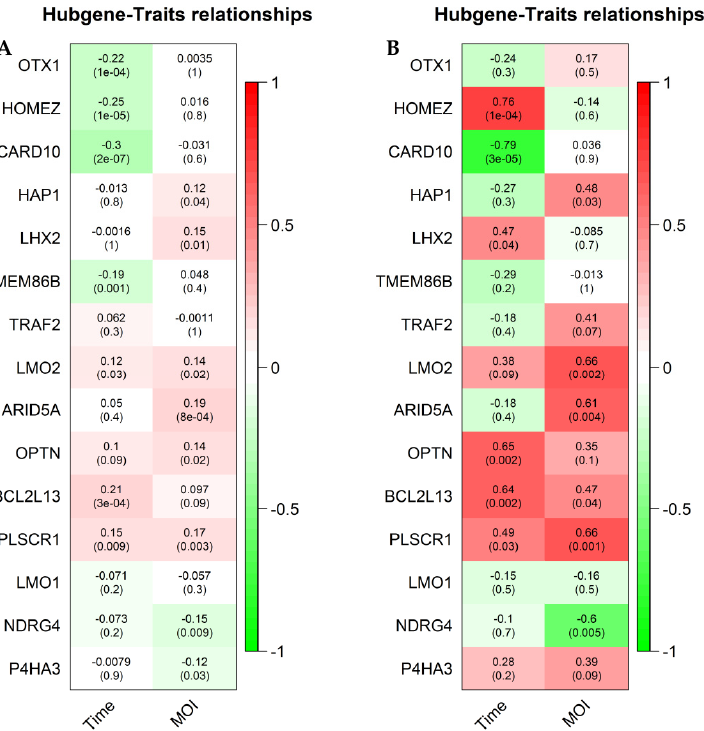
Figure 6. The relationships between top hub genes and traits. The coefficients were the above numbers and the p -values were the below numbers. ( A ) In the training group; ( B ) In the validation group.